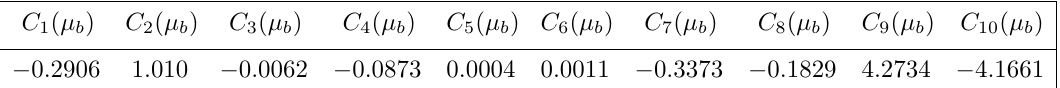
Table 1 . NNLO Wilson coefficients at the scale µ b = 4 . 2 GeV [44,